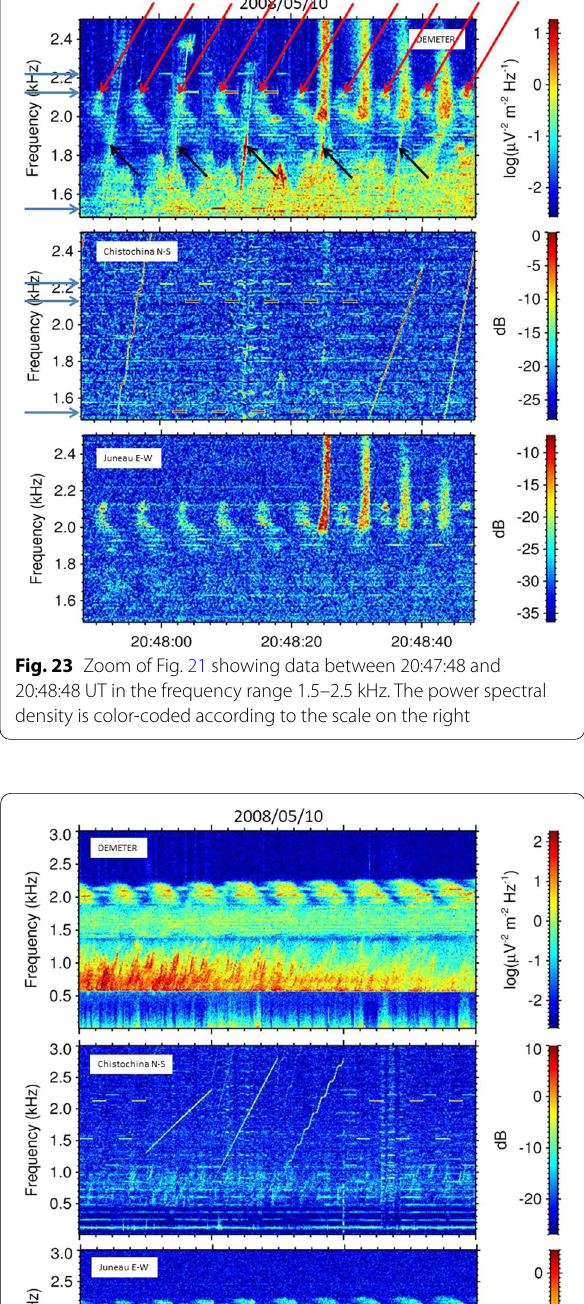
Fig. 24 Zoom of Fig. 23 showing data between 20:49:20 and 20:50:20 UT in the frequency range 0–3 kHz. The power spectral density is color-coded according to the scale on the right